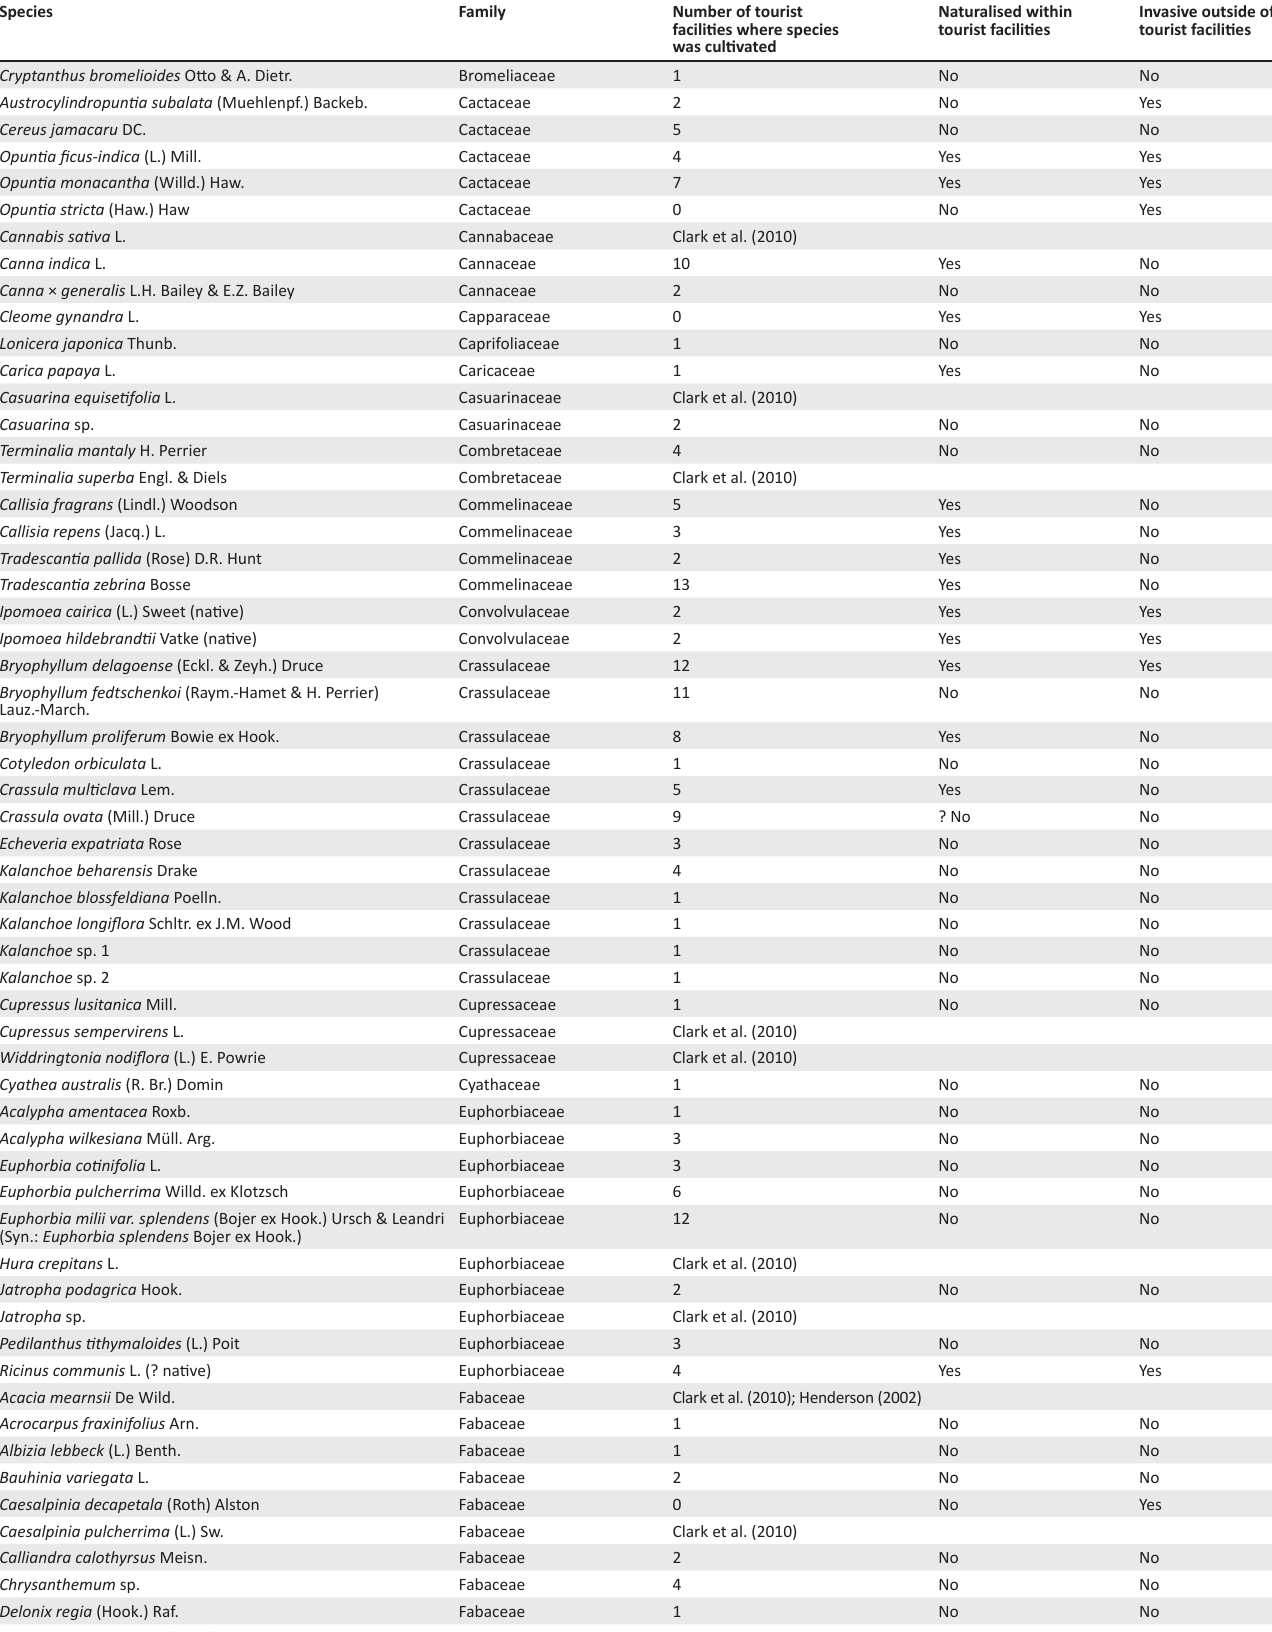
TABLE 1: (Continues...) Alien plant species, including some native plant species which may be growing outside of their natural range, recorded in the Serengeti-Mara ecosystem and immediate surrounds (excluding vegetable crops and grains).